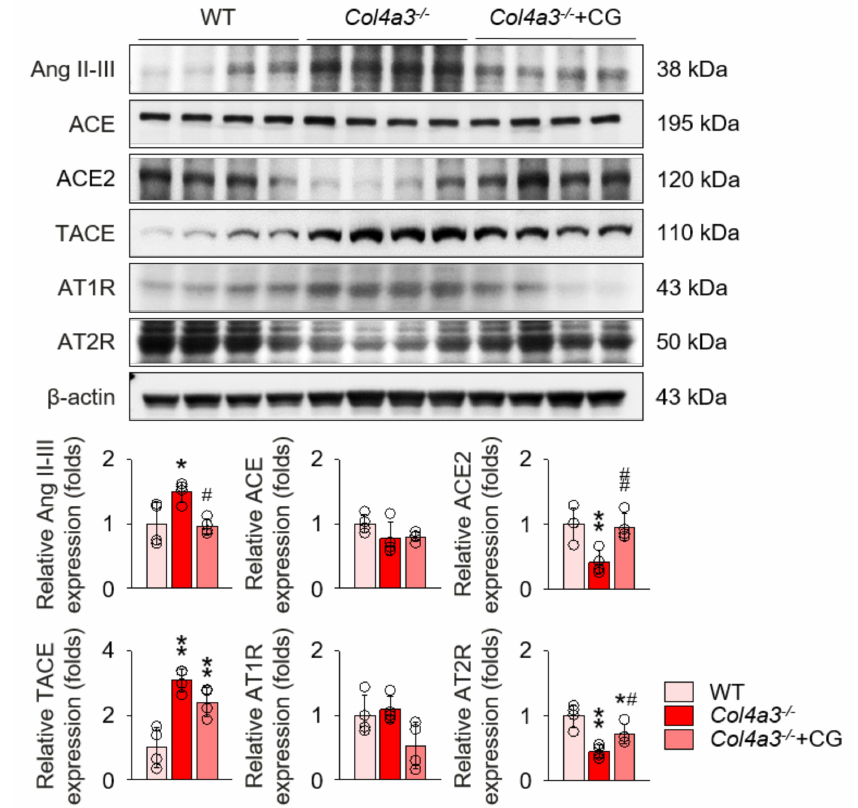
Figure 4. CG inhibited RAS activation in Col4a3 − / − mice. Comparison of protein expression level of RAS components determined by immunoblotting from the kidney of WT, Col4a3 − / − , and Col4a3 − / − + CG mice ( n = 4 mice / group). β -actin was used as the endogenous control. * p < 0.05, ** p < 0.01 vs. WT mice; # p < 0.05, ## p < 0.01 vs. Col4a3 − / − mice by one-way ANOVA with Newman–Keuls multiple comparison